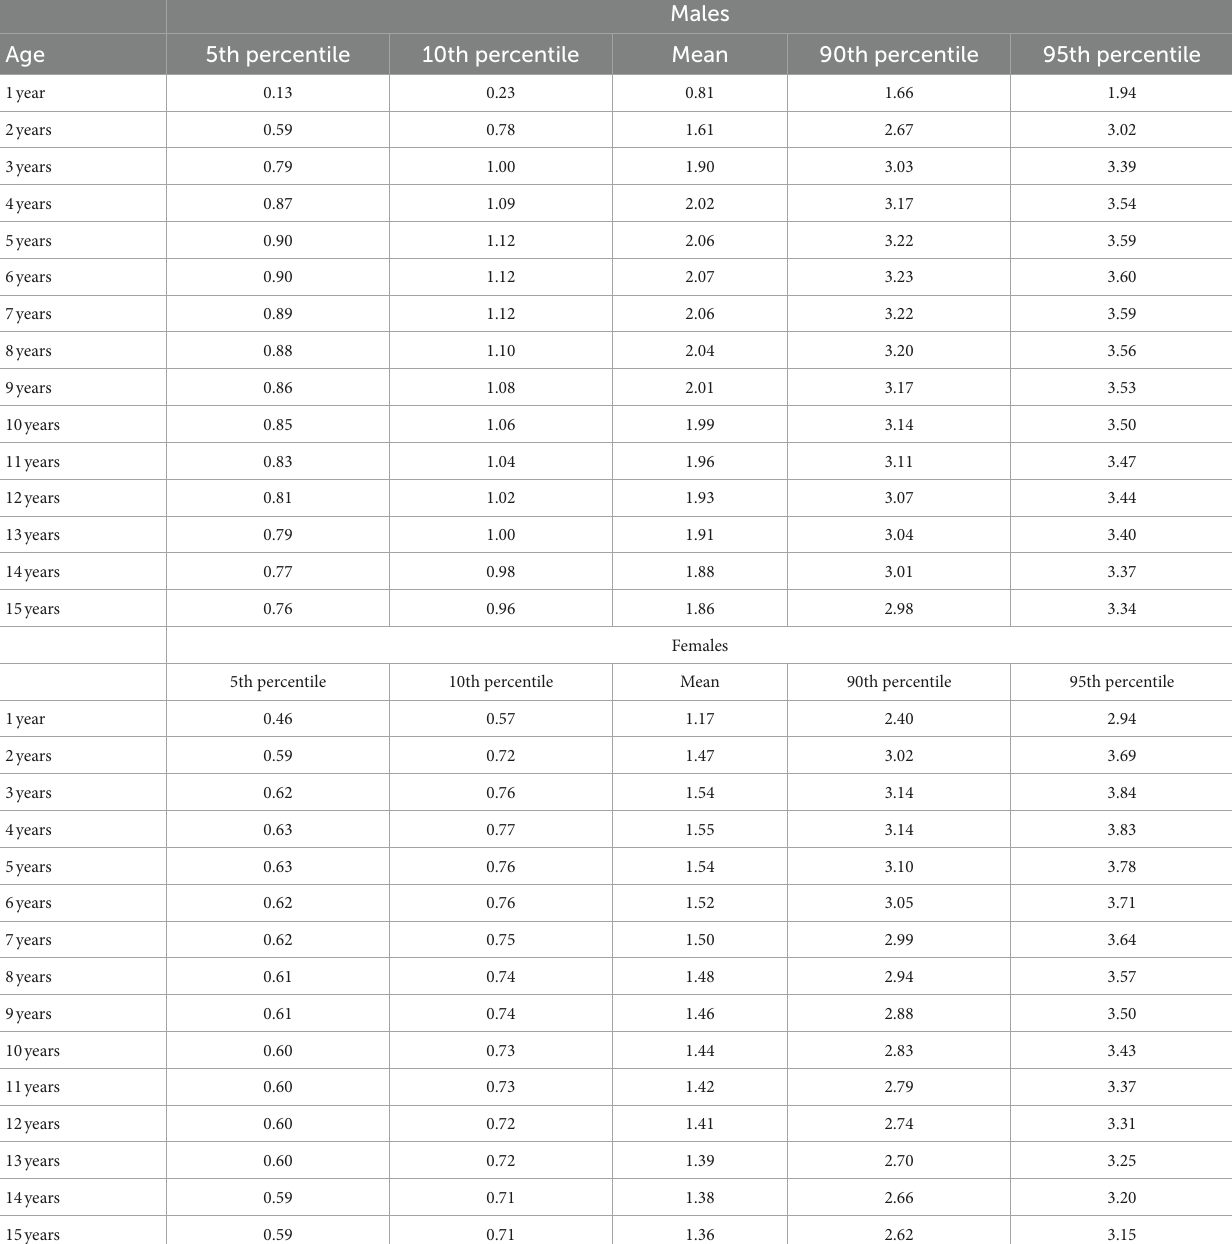
TABLE 3 Normative values for air conduction (AC) c-VEMP amplitude-ratio as modeled for age-specific reference intervals using the Royston and Wright method (26).